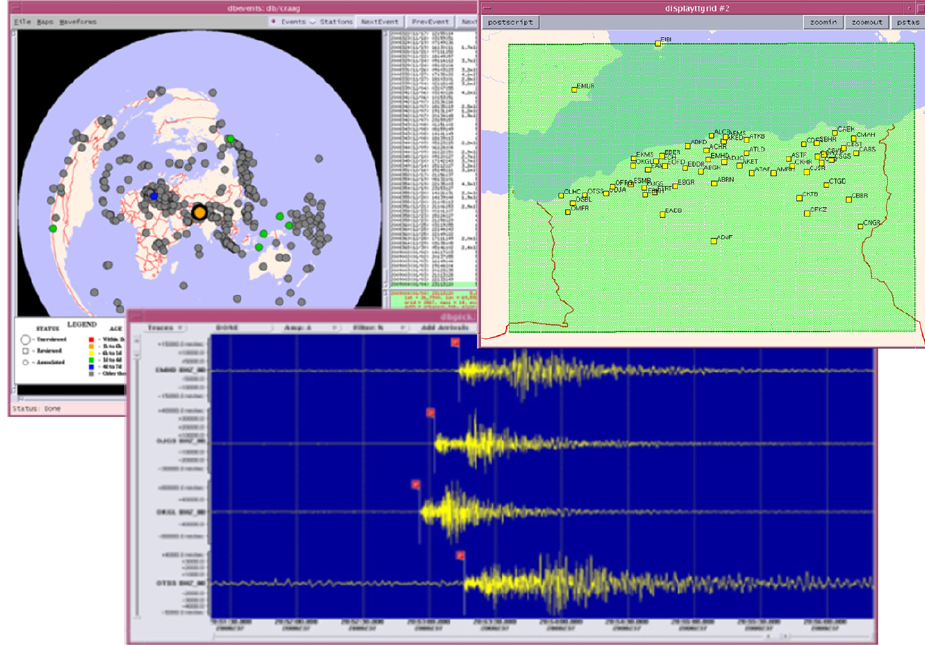
Fig. 5. Automatic processing using different screens for editing the signal, the network and the location in the region.